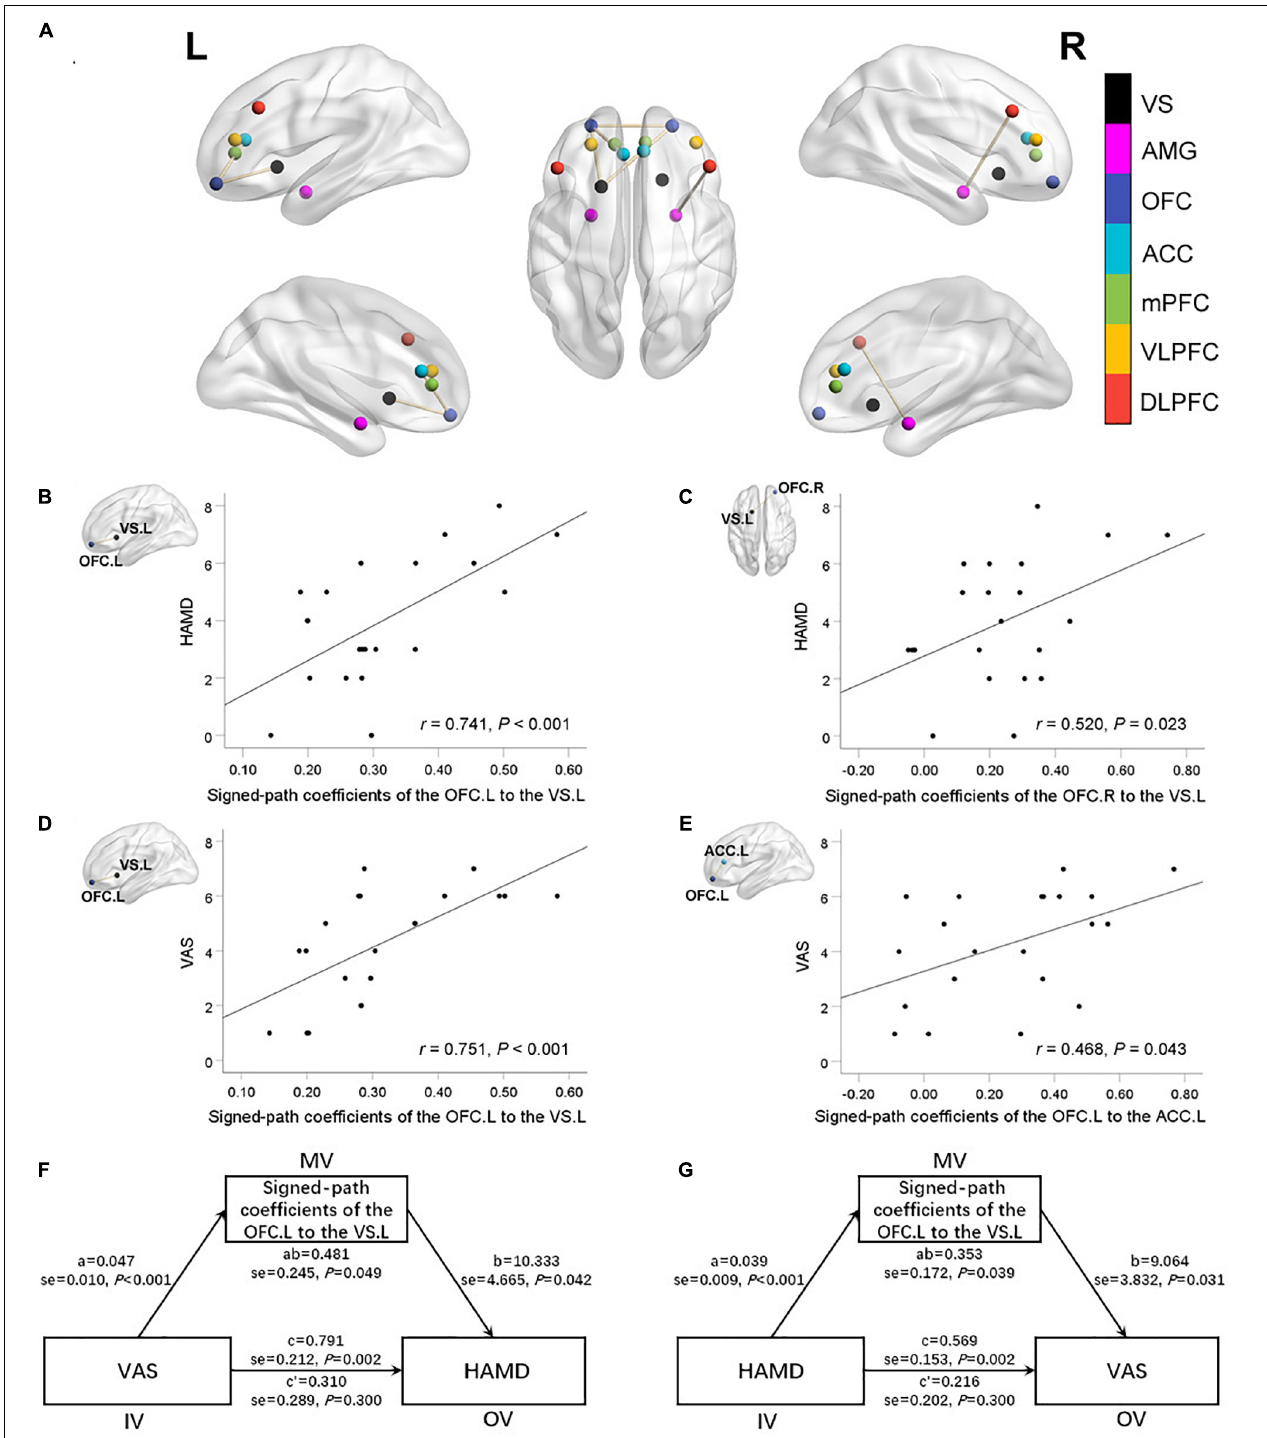
FIGURE 3 | Abnormal functional connectivity (FC) between selected brain regions in mood-regulating circuits (MRC) between the two groups (A) . There were significant positive correlations between the FC of the left VS with left OFC (B) , right OFC (C) and the HAMD scores. There were significant positive correlations between the FC of the left OFC with left VS (D) , left ACC (E) and the VAS scores. The oral-facial pain and depressive symptoms are mutually significant overall effects. Both relationships were completely mediated by the FC between the left OFC and left VS (F,G) . VS, ventral striatum; AMG, amygdala; OFC, orbitofrontal cortex; ACC, anterior cingulate cortex; mPFC, medial prefrontal cortex; VLPFC, ventral lateral prefrontal cortex; DLPFC, dorsolateral prefrontal cortex; HAMD, Hamilton Depression Rating Scale; VAS, Visual Analog Scale; R, right; L, left.